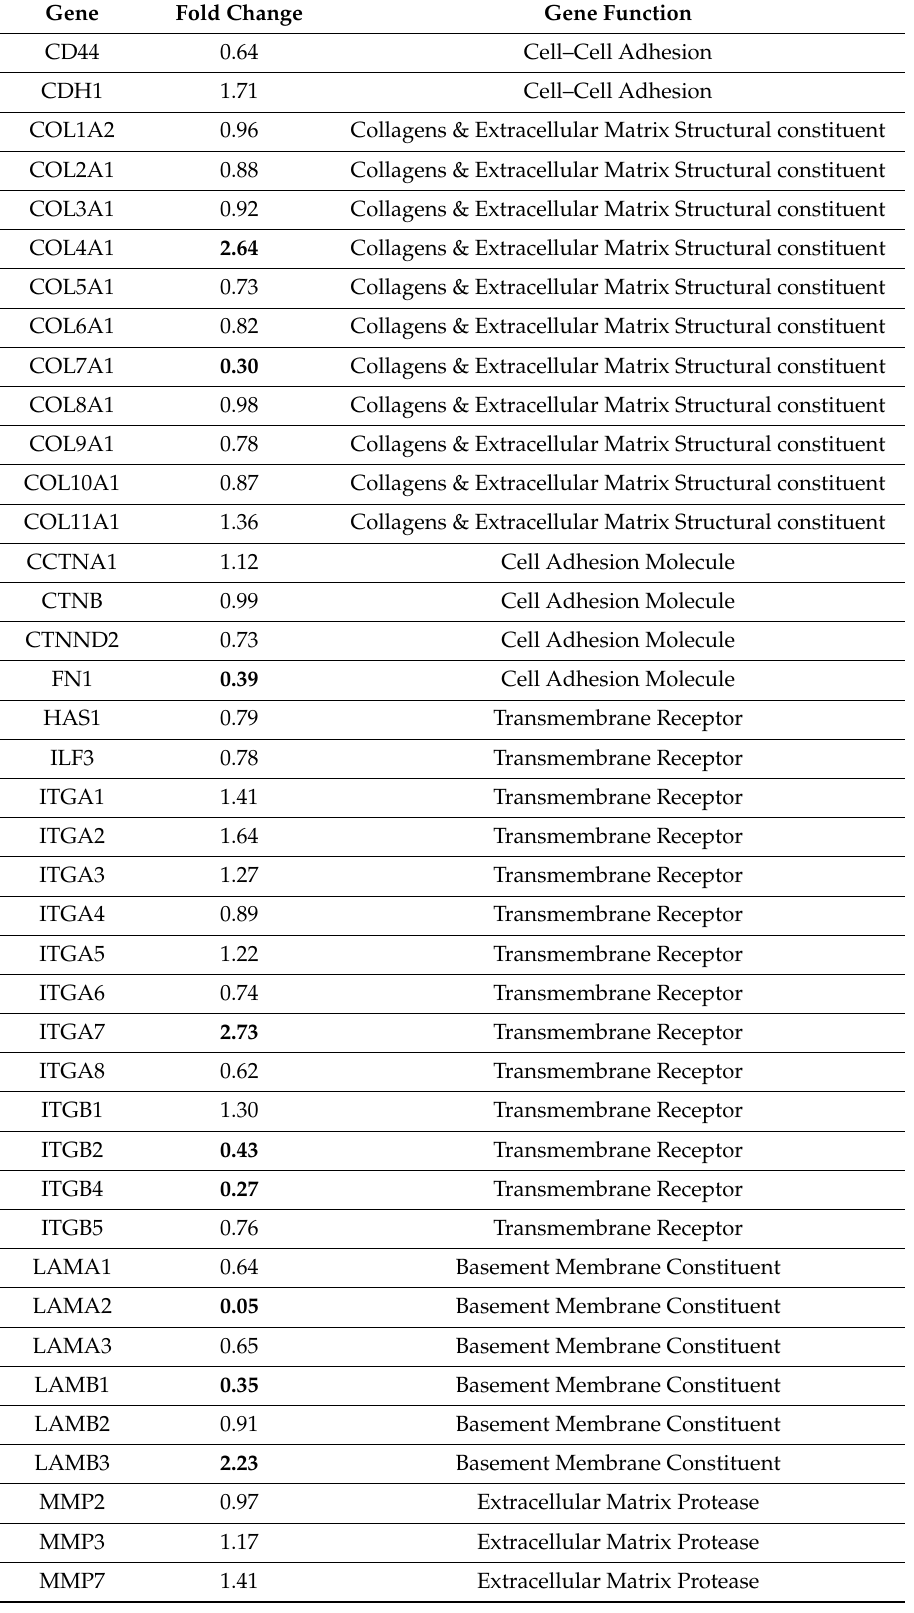
Table 2. Gene expression profile of 57 genes belonging to the “Extracellular Matrix and Adhesion Molecules” pathway analyzed using Real time PCR after 24 h of treatment with